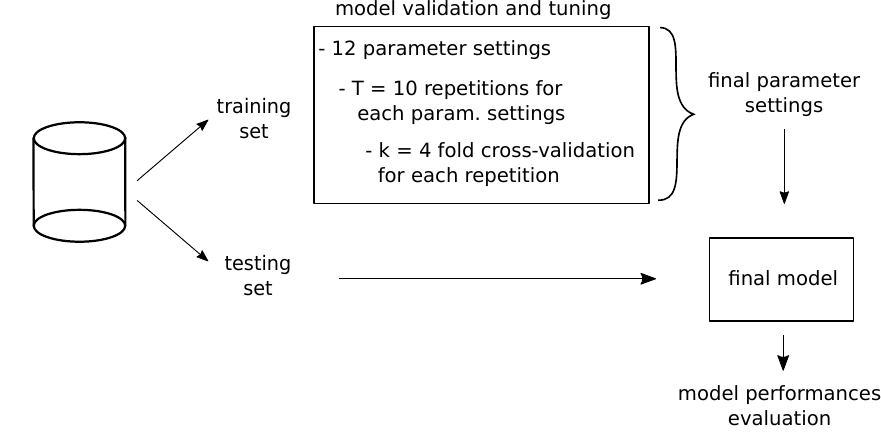
Figure 3. Overview of the entire